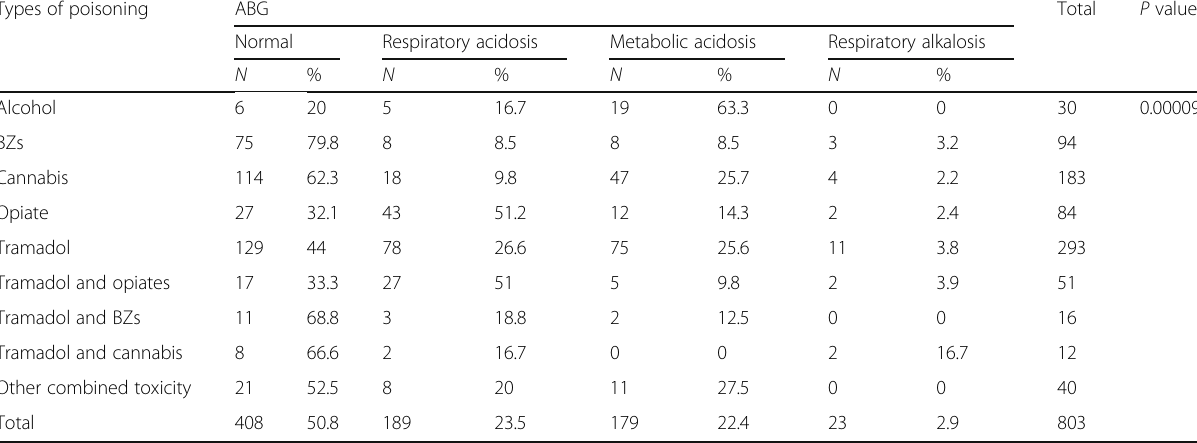
Table 6 The effect of addictive drug-induced acute toxicity on ABG of patients under the